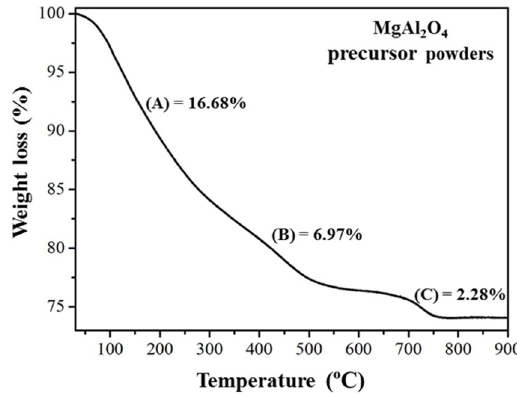
O precursor 2 4